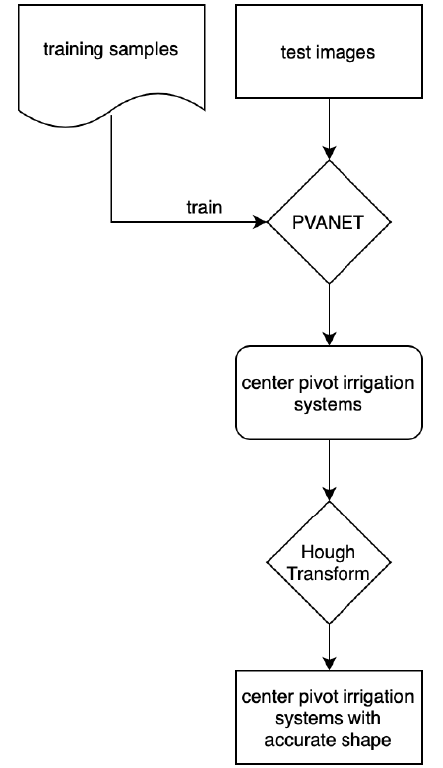
Figure 2. Flowchart of the PVANET-Hough